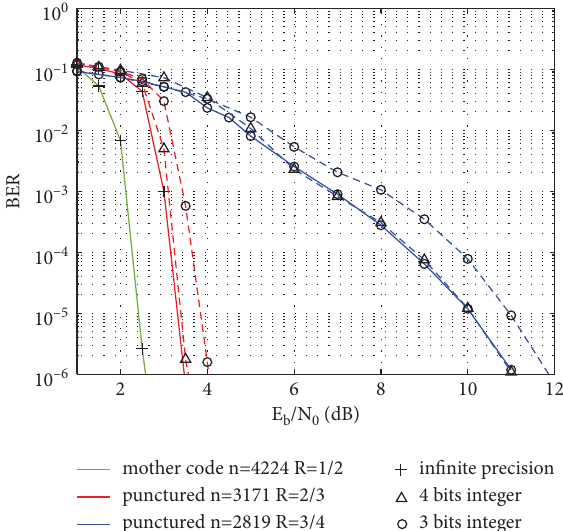
Figure 15: BER performance of puncturing LDPC codes. Te solid lines represent infnite precision and the dashed lines mean integer quantization.